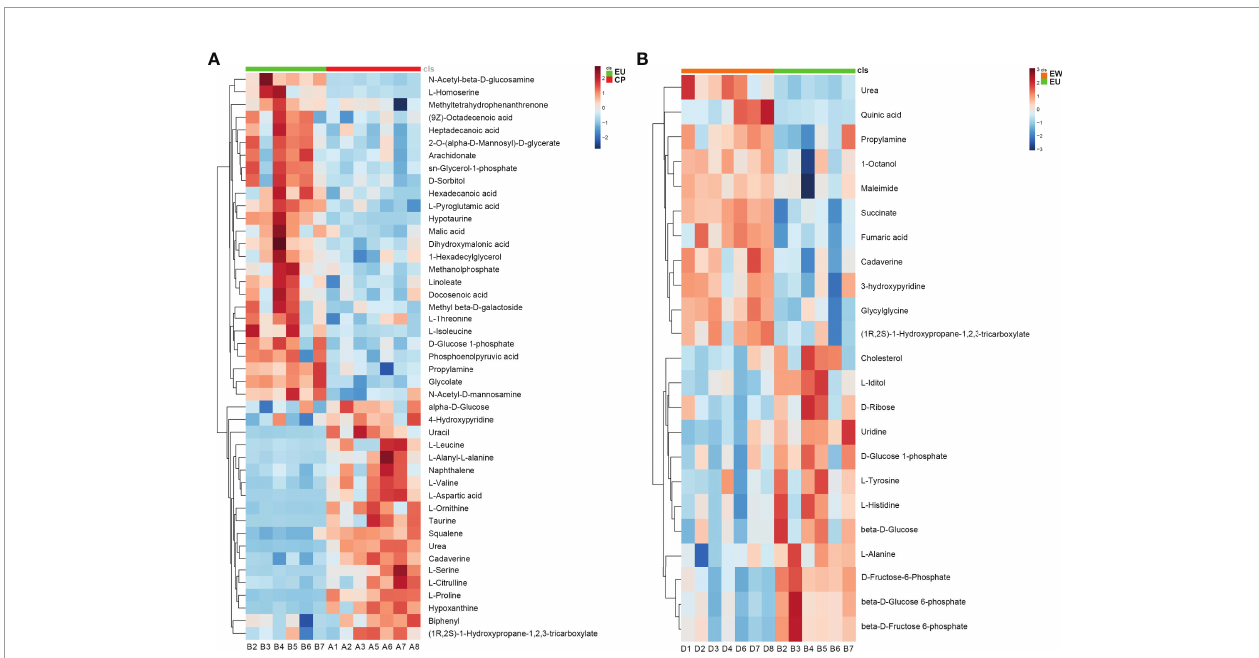
FIGURE 5 | Heatmaps plotted using signi fi cantly changed metabolites. Each metabolite is represented by a row of colored boxes. Columns represent samples, and rows represent metabolites. Red indicates an increase in the relative level of metabolites, while blue indicates a decrease. (A) Heatmap of EU vs. CP and (B) EW vs. EU groups. A = CP, B = EU, and D =